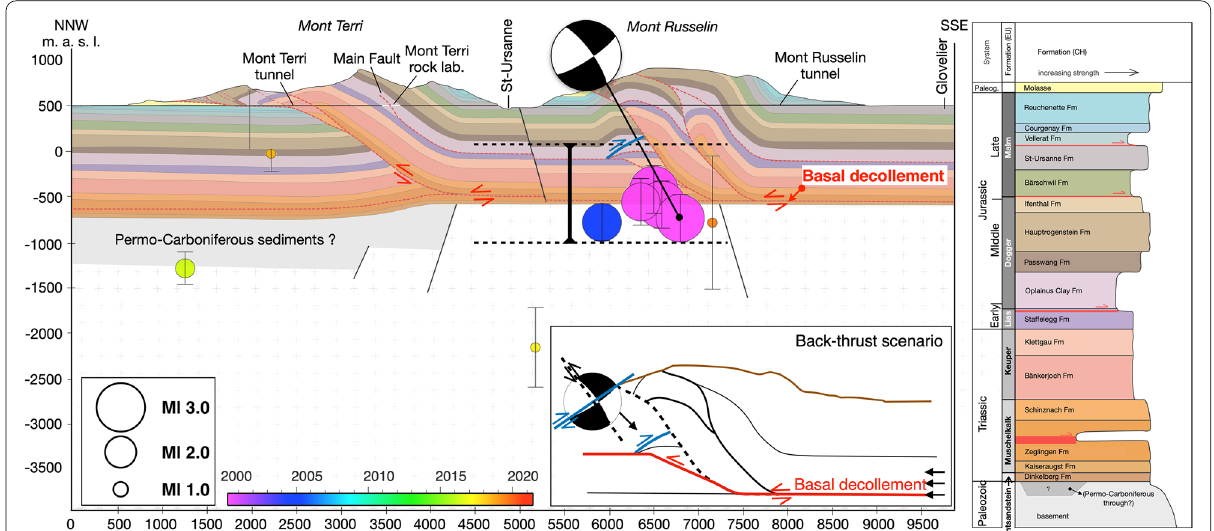
Fig. 11 Forward modelled NNW-SSE cross section along the Mont Terri tunnel from Nussbaum et al. (2017). Absolute locations obtained in this study (see Fig. 4 for details) for shallow earthquakes are overlaid. Vertical bars indicate absolute errors of focal depths. The thick error bar indicates the combined depth uncertainties obtained from both absolute and relative relocations. Colors indicate origin time. Size of symbols is proportional to magnitude. The focal mechanism of the strongest event based on first-motion polarities suggests a north-dipping low-angle thrust mechanism. As the sense of motion disagrees with the basal decollement, a backthrust rooting in the top of the Lias Group (Staffelegg Formation in the Lithostratigraphic Lexicon of Switzerland) in the footwall of the Mont Russelin ramps is more likely to be the active plane of the 2000 seismic sequence. Note that the lexicon of the lithostratigraphic column follows the lexicon of Switzerland. The corresponding European lexicon of the lithostratigraphic groups for the Triassic and Jurassic epochs is also indicated. For more information about the definition of the units in the Lithostratigraphic Lexicon of Switzerland, as well as further cross-links to other units, please visit www. strati. ch. Figure modified from Nussbaum et al.